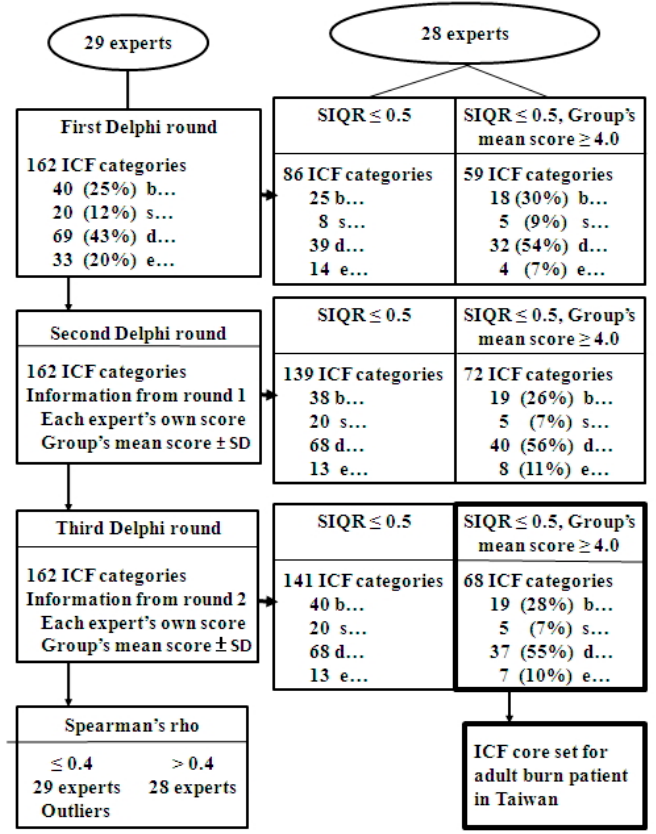
Figure 2. Consensus process of the development of the International Classification of Functioning, Disability, and Health core set for adult patients with burns in Taiwan. The number of selected categories is indicated at each step. The group mean score was the average of all expert scores. Letters b…, s…, d…, and e… indicate the categories of the body functions, body structures, activities and participation, and environmental factors components. SIQR, semi-interquartile range.